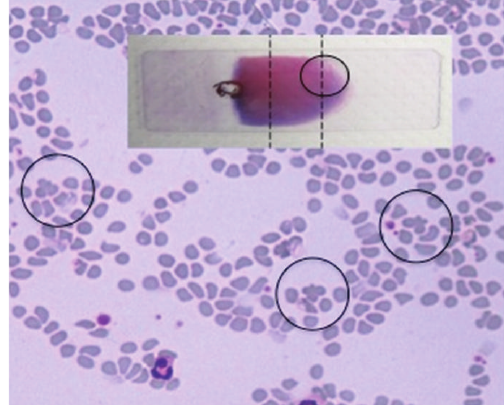
Figure 2: Few qRBCs seen (black circle) in the feathered edge area of the blood film (20x, May-Grundwald